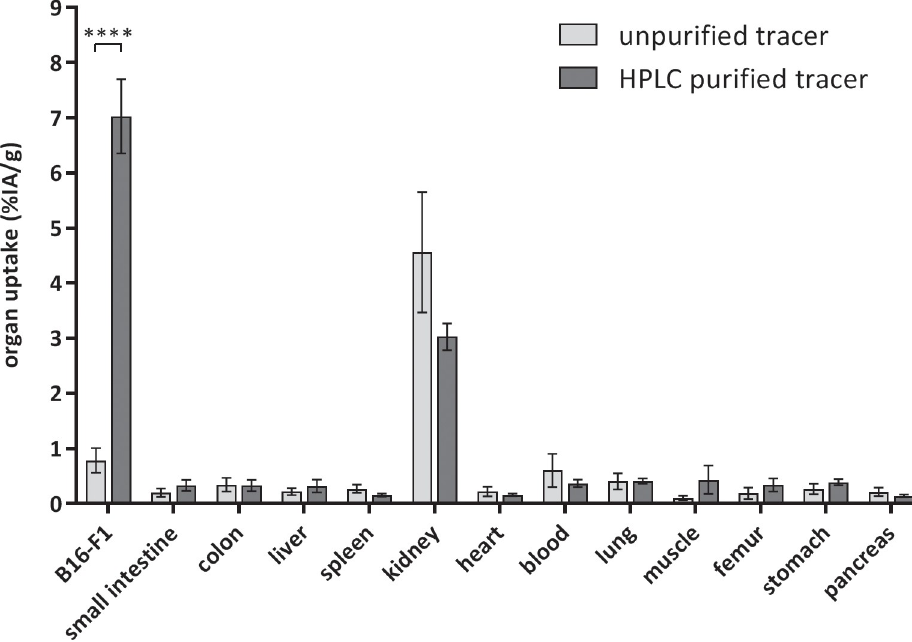
Fig 3. Biodistribution at 1 h after i.v. injection of approximately 5 MBq radiotracer. Results of 68 Ga- DOTA-NAPamide produced by the standard protocol (n = 7) are shown in light gray, and results obtained with the purification protocol (n = 7) are shown in dark gray (mean +/- SEM; ���� p = 0.0001, two-way ANOVA followed by Bonferroni post-test).